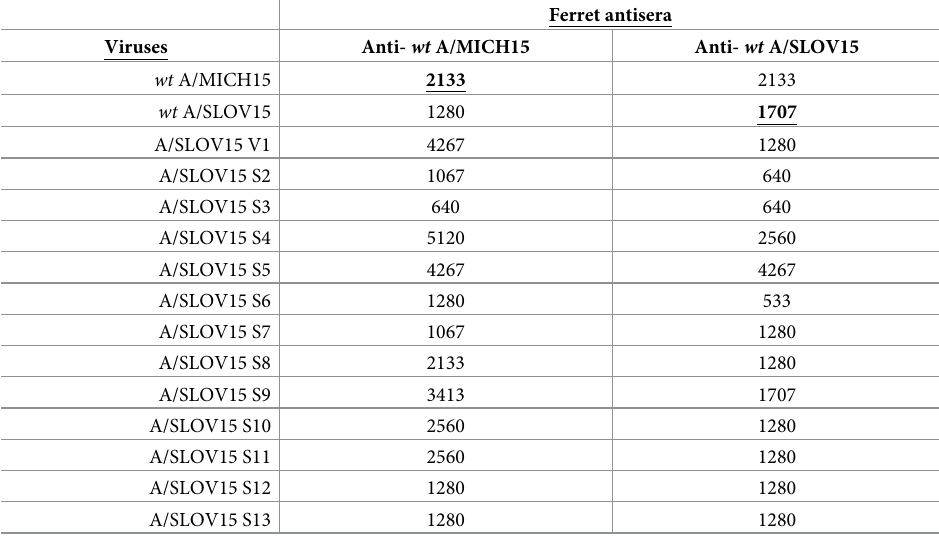
Table 3. Introducing N125D, D127E, D222G and R223Q in any permutation did not significantly alter antigenic- ity of A/SLOV15 LAIV mutants when tested by one-way HAI.